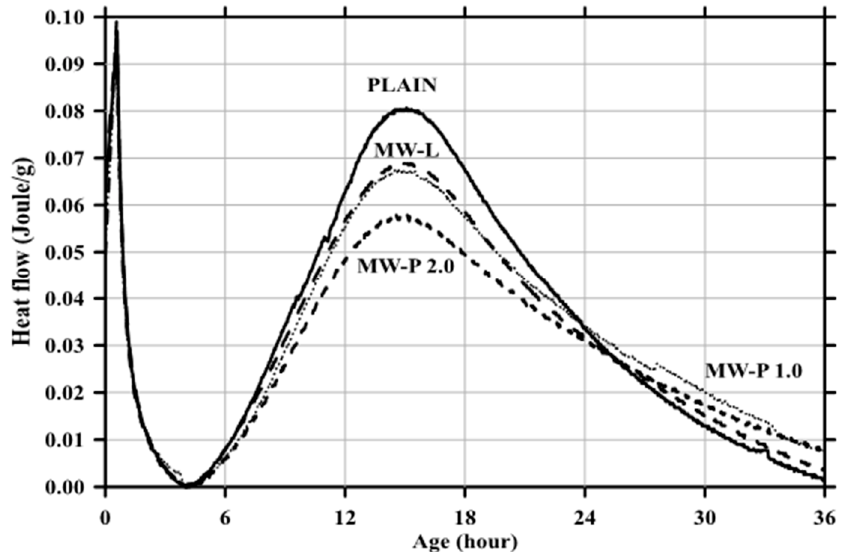
Figure 6. Rate of heat evolution.